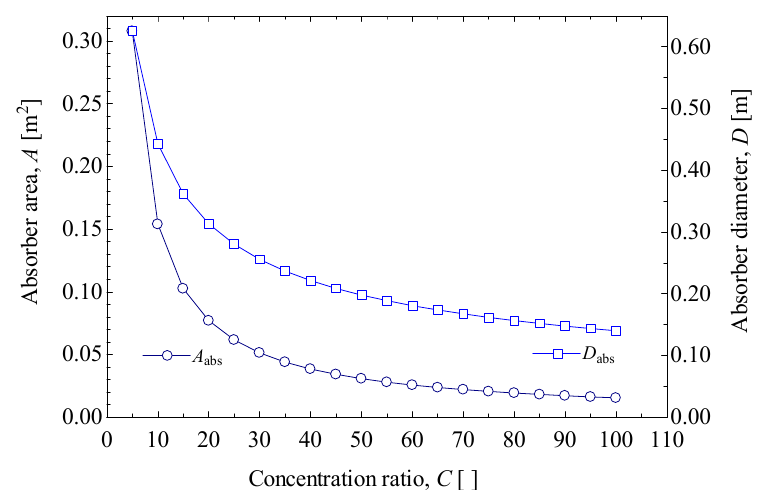
Figure 7. Area and diameter of the solar absorber in relation to the concentration ratio.